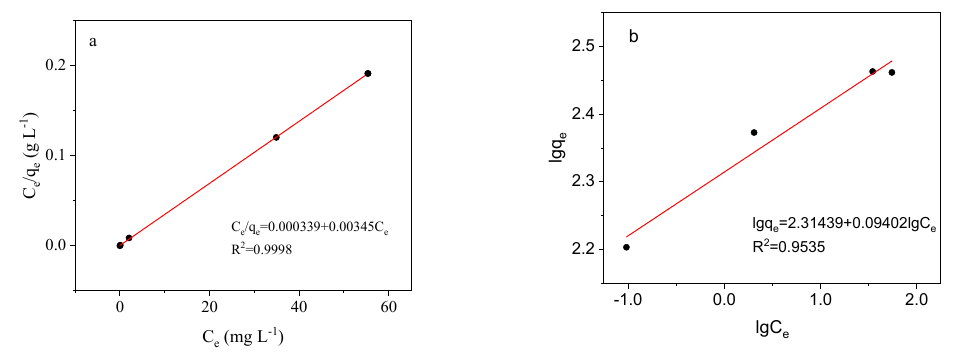
Figure 9. Langmuir ( a ), and Freundlich isotherm models ( b ). Table 3. Langmuir and Freundlich isotherm parameters of TEBAC-HKUST-1.